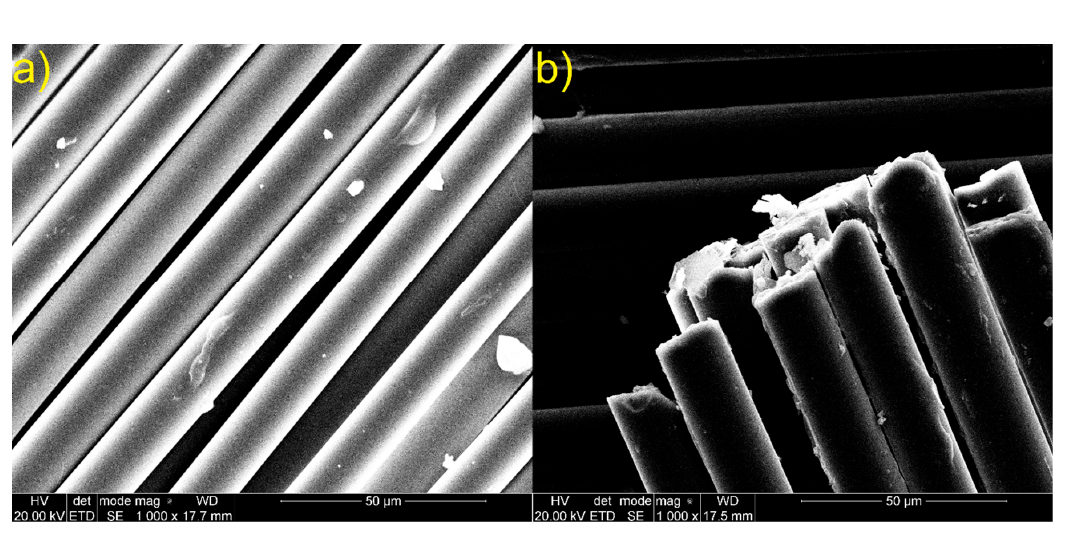
Figure 14. SEM images of sisal fiber ( a ) transversal cross-section of sisal in material; ( b ) longitudinal section of sisal.